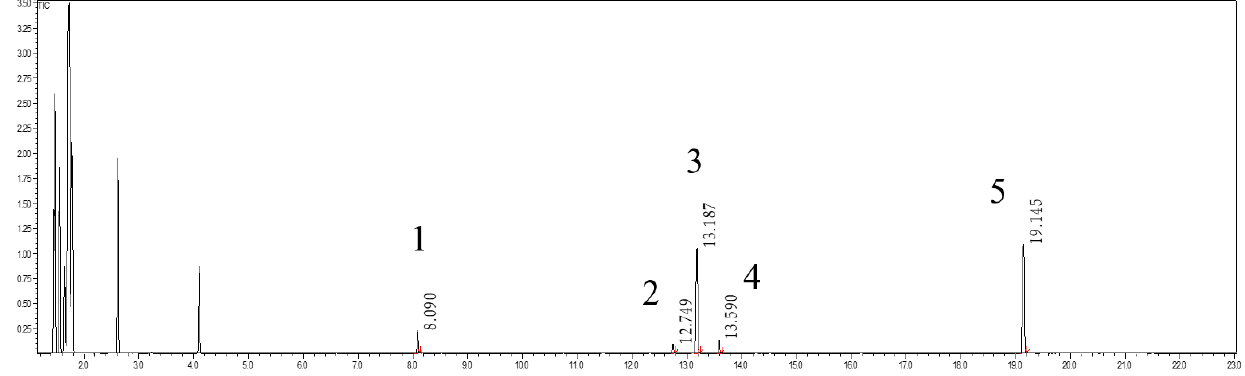
Figure 5. Chromatogram obtained from analysis of derivatized sample from hydrolytic suspension with enzyme A. niger after 4 min of starting the reaction. Peaks 1-Eugenol TMS deriv., 2- α -D-glucose-5-TMS deriv., 3-D-sorbitol-6-TMS deriv., 4- β -D-glucose-5-TMS deriv., 5-eugenyl β -D-glucoside-4-TMS deriv.